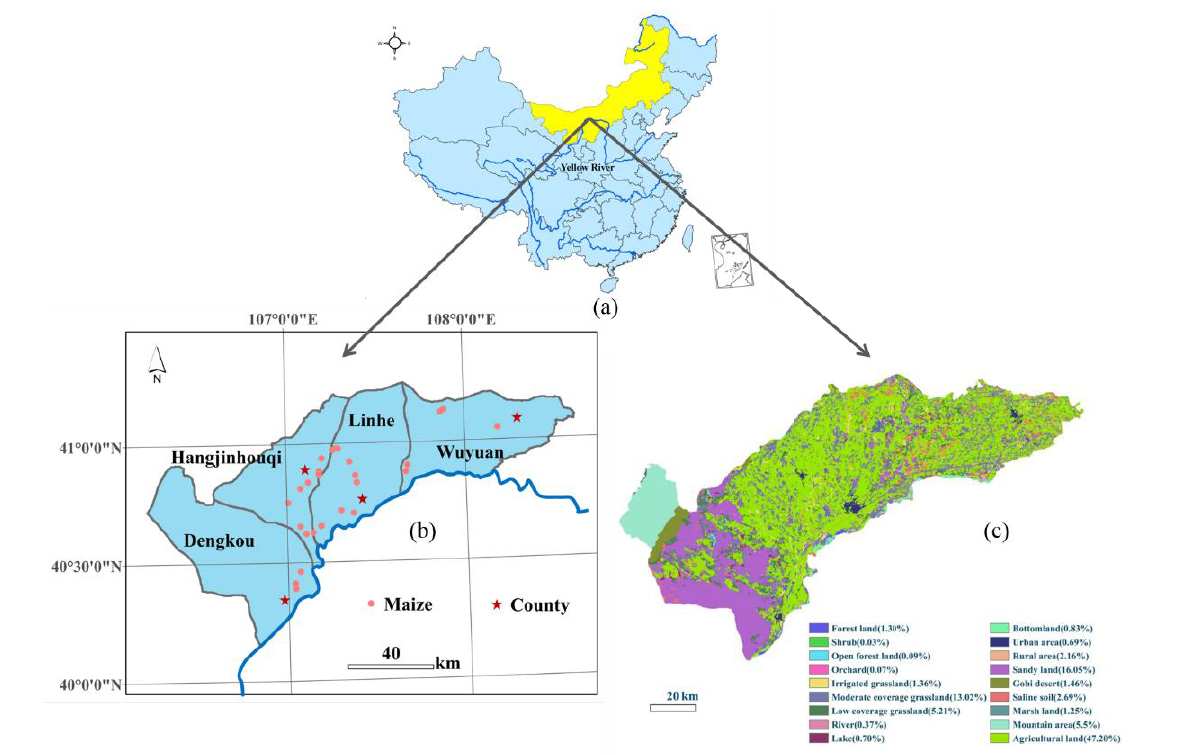
Figure 1. Location of the study region ( a ), location of maize sampling points ( b ),and land cover classification in the study region as of 2000 ( c ).